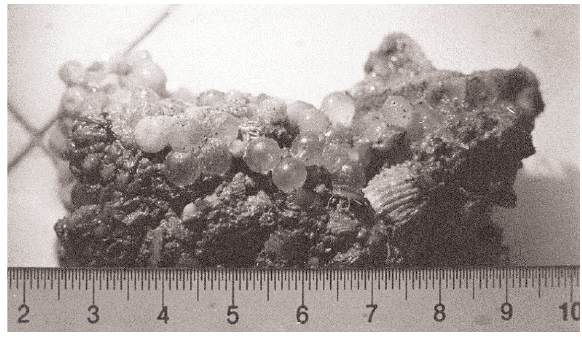
F IG . 2. – A 21 egg clutch of Sepietta oweniana attached to Microcosmus sp., collected in the Catalan Sea.